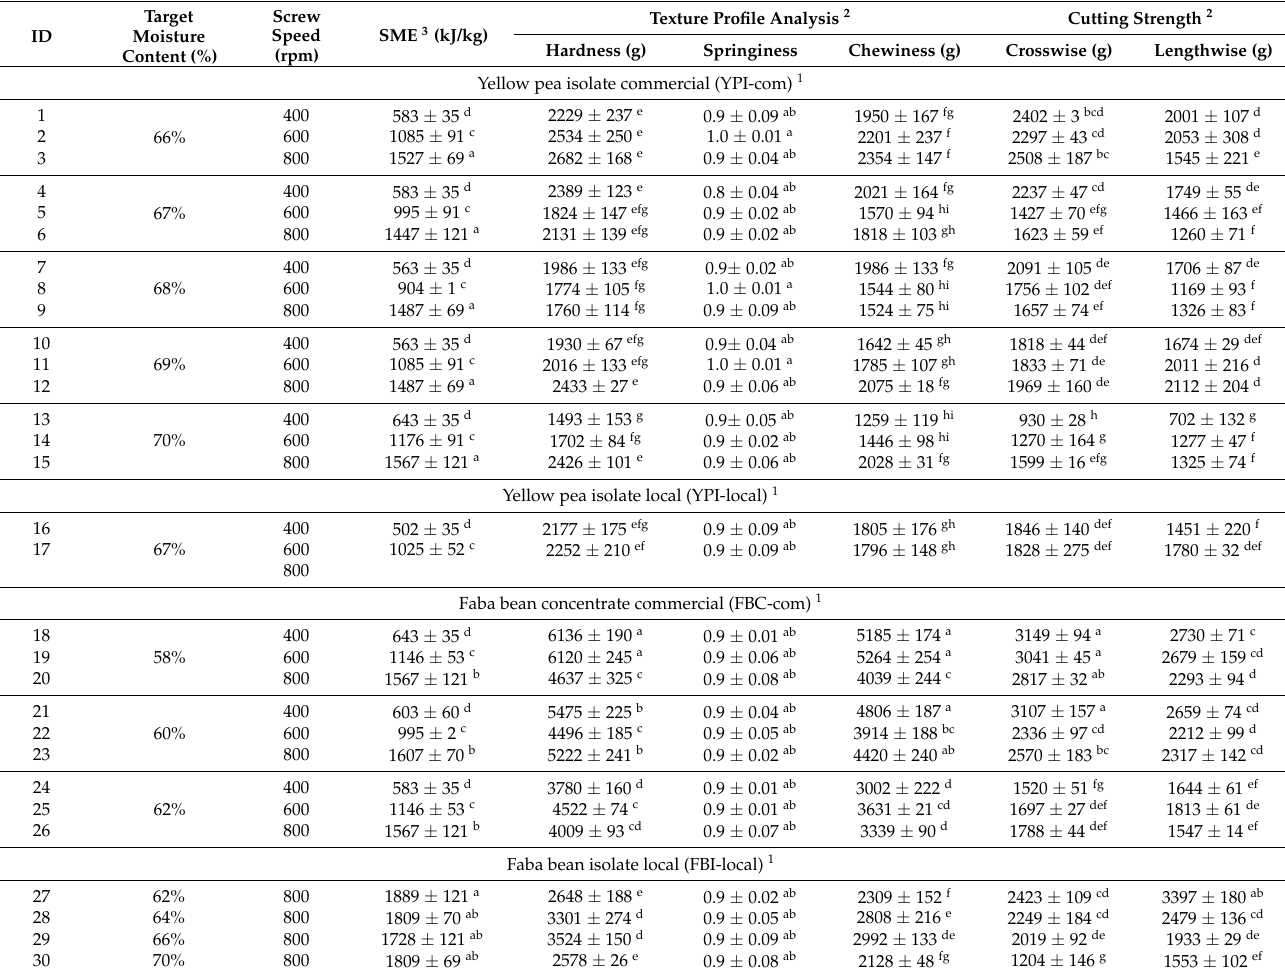
Table A4. Effect of extrusion temperature, screw speed and target moisture content on the textural properties of